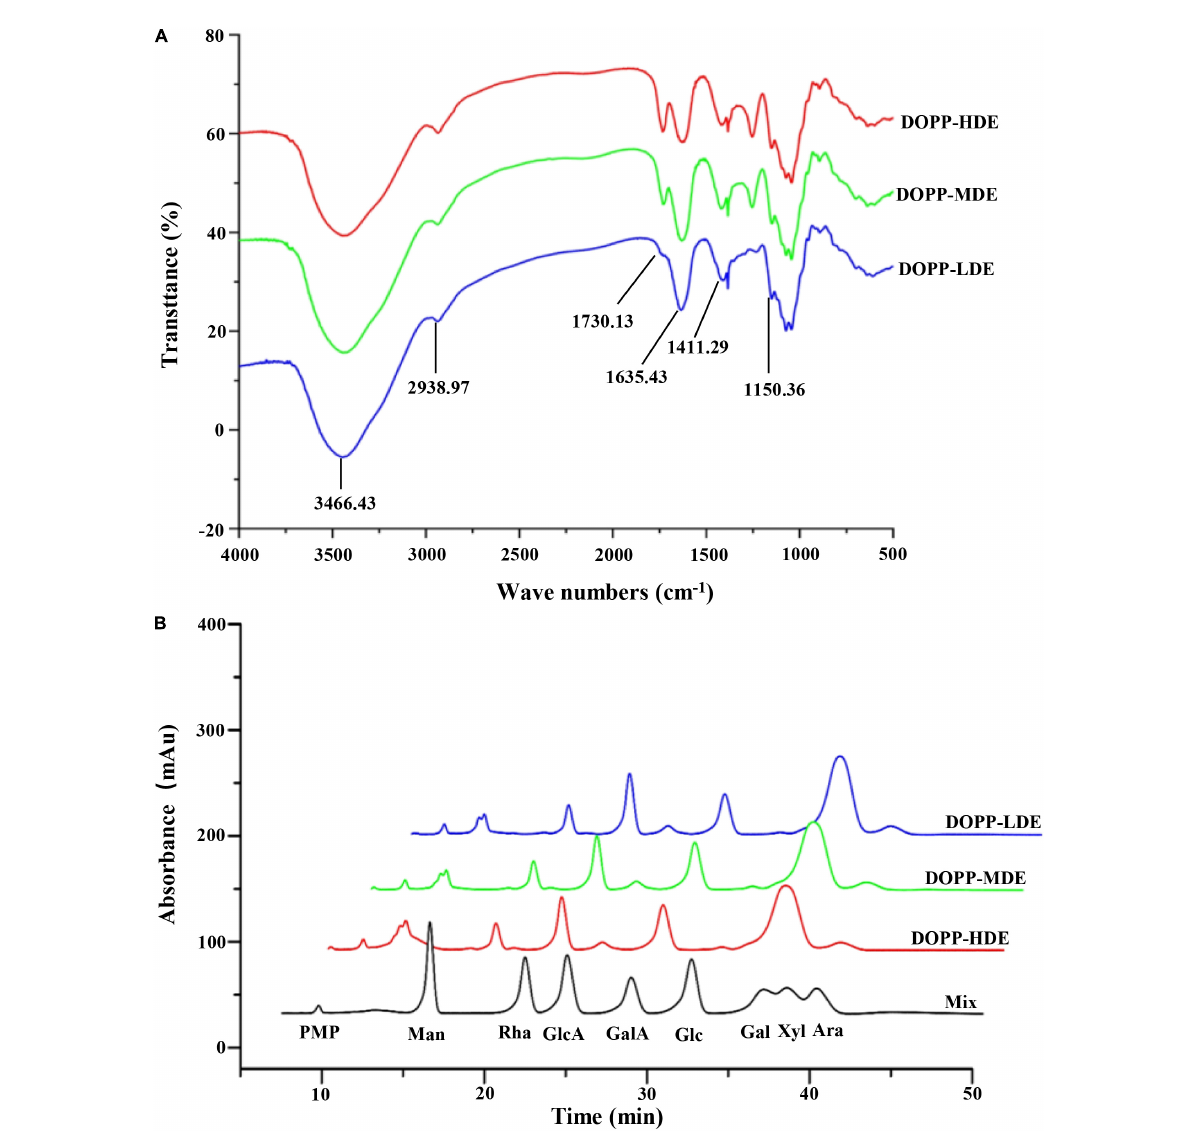
FIGURE1 FT-IR spectra (A) and high-performance liquid chromatograms of compositional monosaccharides (B) of okra pectic-polysaccharides (OPP) with various degrees of esterification. DOPP-HDE, DOPP-MDE, and DOPP-LDE indicate OPP with high, middle, and low degrees of esterification, respectively; Mix indicates the monosaccharide standards, which was analyzed by HPLC under the same conditions of samples. PMP, 1-phenyl-3-methyl-5-pyrazolone; Man, mannose; Rha, rhamnose; GlcA, glucuronic acid; GalA, galacturonic acid; Glc, glucose; Gal, galactose; Xyl, xylose; Ara,